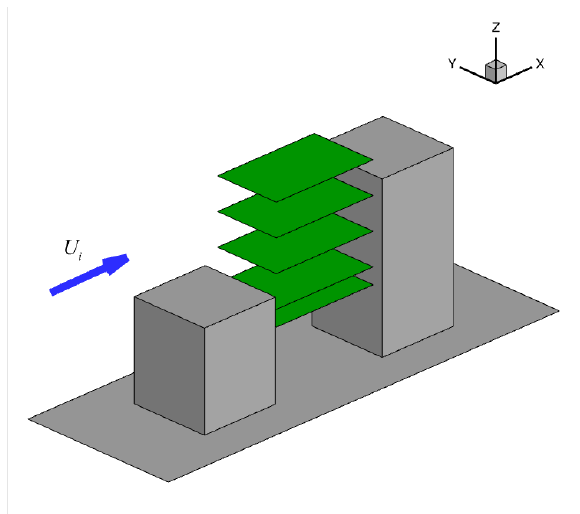
Fig. 1. The three-dimensional image of the experiment setup, planes of measurement are in green.